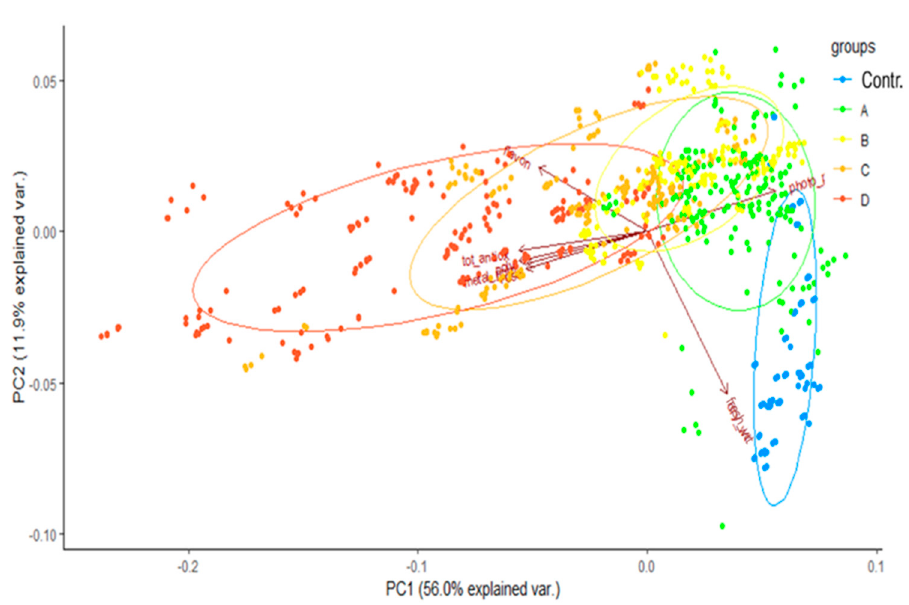
Figure 3. PCA analysis showing the grouping for P. aviculare data according to di ff erent metal treatments. The complete dataset reported in Supplementary Table S1 was used to perform the analysis by means of the prcomp function of the R package. Treatments: control, no metal; A, urban metal concentration; B, medium metal concentration, C, high metal concentration, D, maximum metal concentration allowing plant survival.